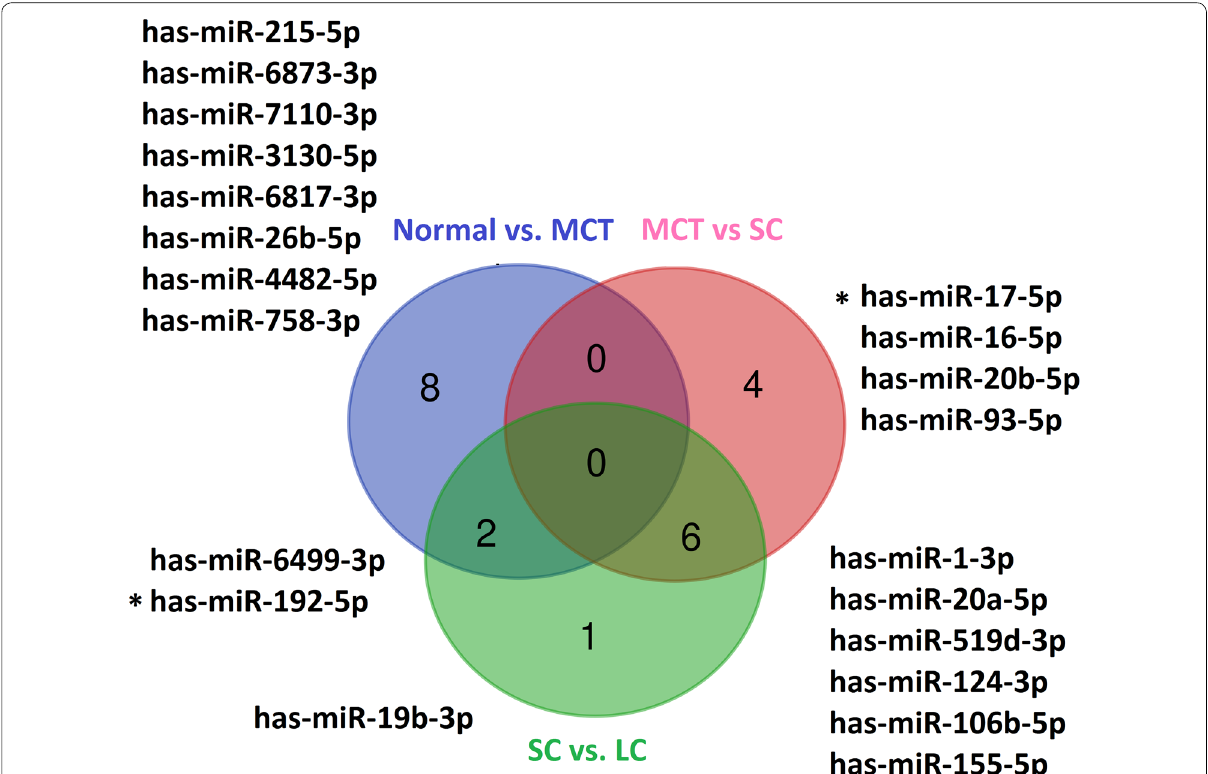
Fig. 4 miRNA enrichment analysis results. The top of the miRNA were predicted. An adjusted p-value less than 0.05 was considered as the significant